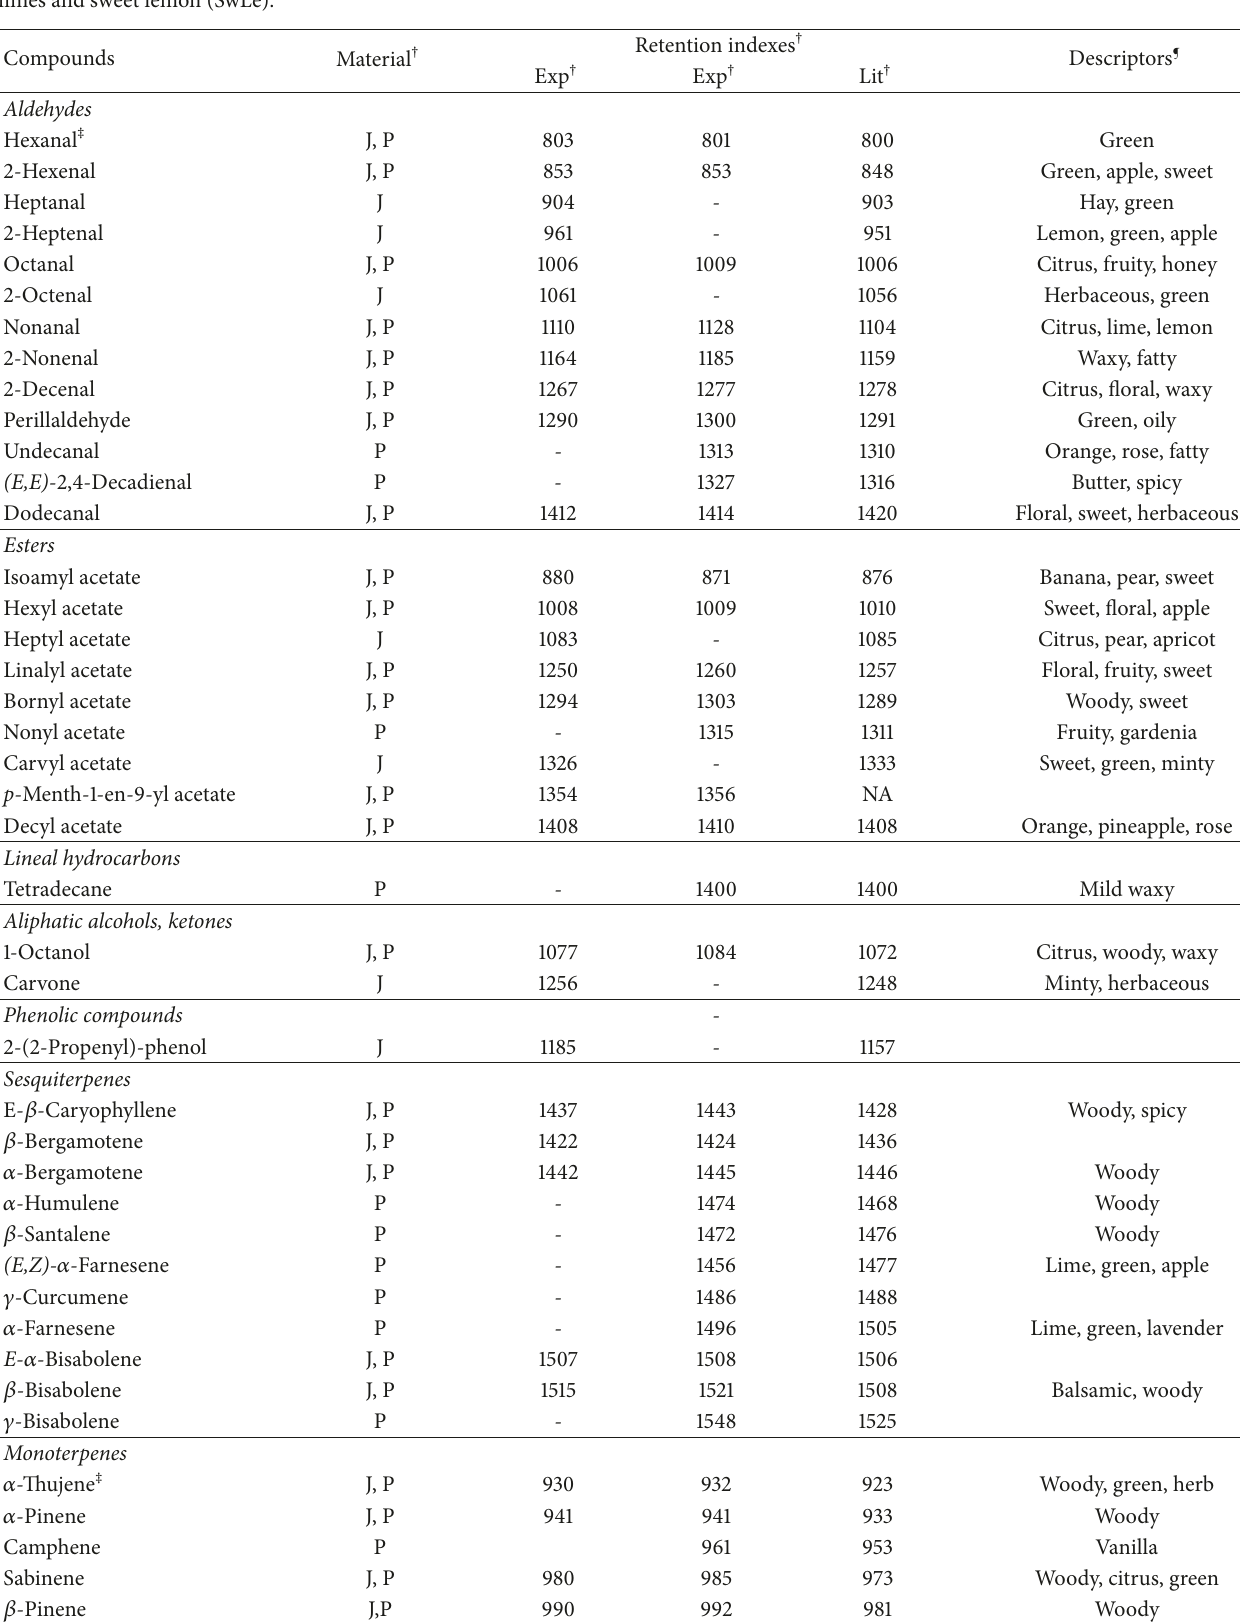
Table 3: Retention indexes [8] and sensory descriptors [9–11] of the volatile compounds of endangered Spanish sour (SoLi) and sweet (SwLi) limes and sweet lemon